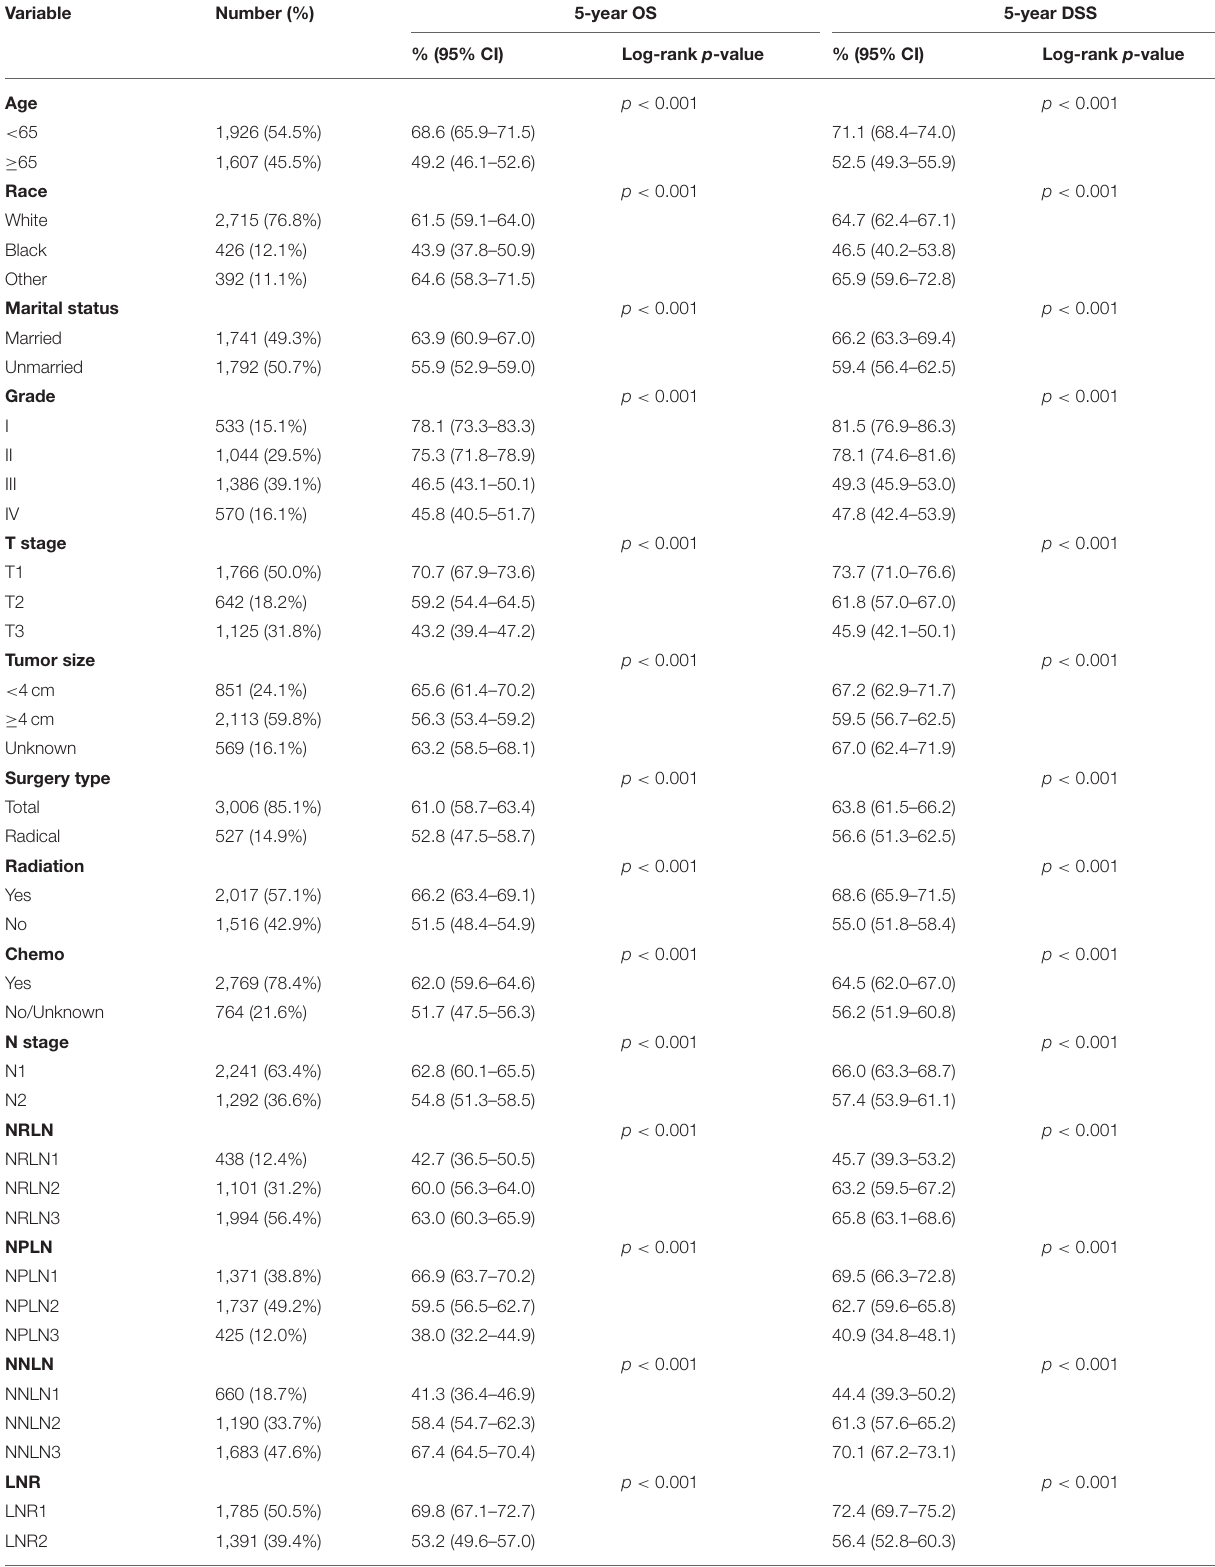
TABLE 1 | Clinical and pathological characteristics and survival analysis of patients.